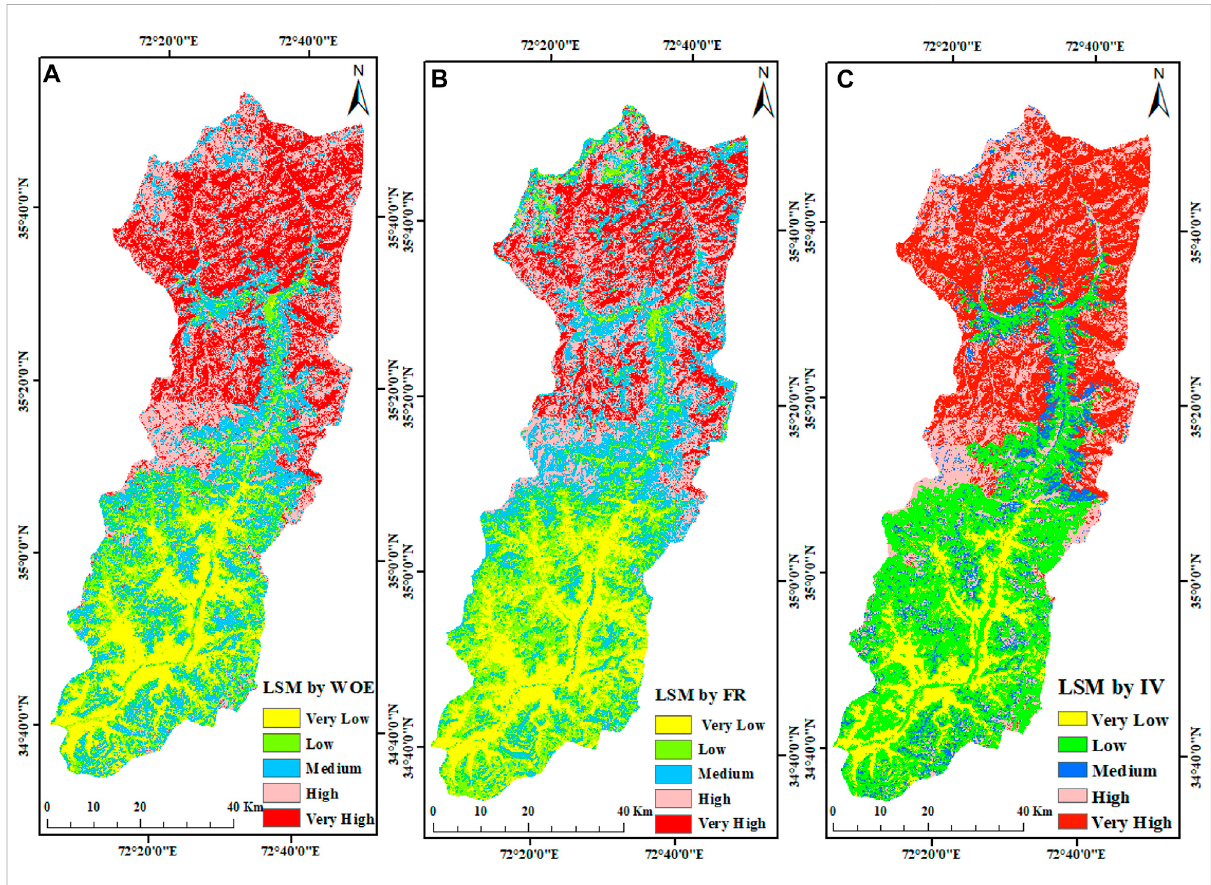
FIGURE 6 Landslide susceptibility mapping derived from bivariate models: (A) LSM by WOE; (B) LSM by FR; (C) LSM by